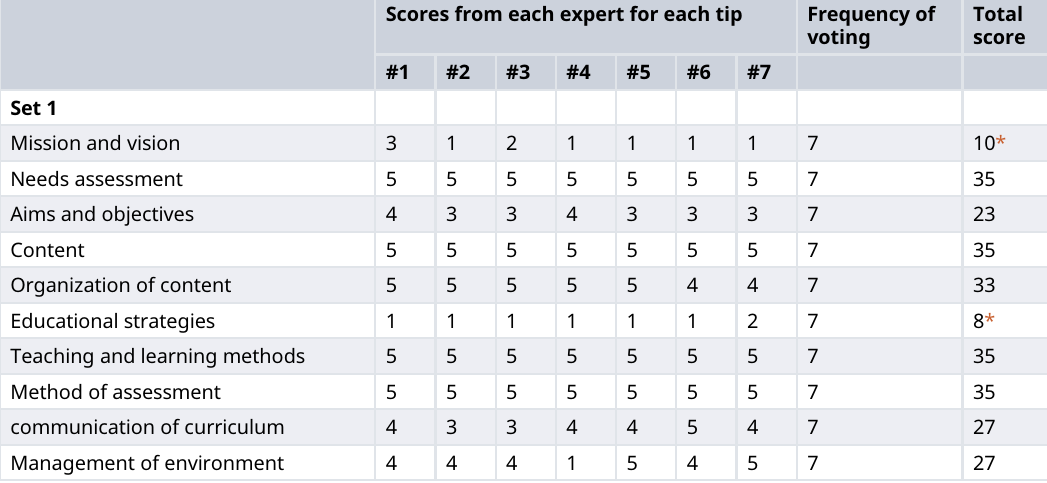
Scores from each expert for each tip Frequency of